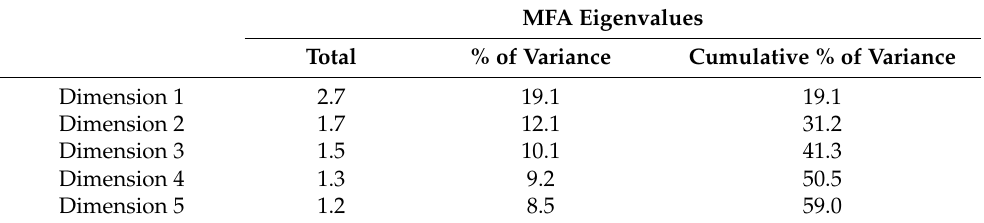
Table 3. Eigenvalues obtained from multiple factor analysis and percentages of variance explained.